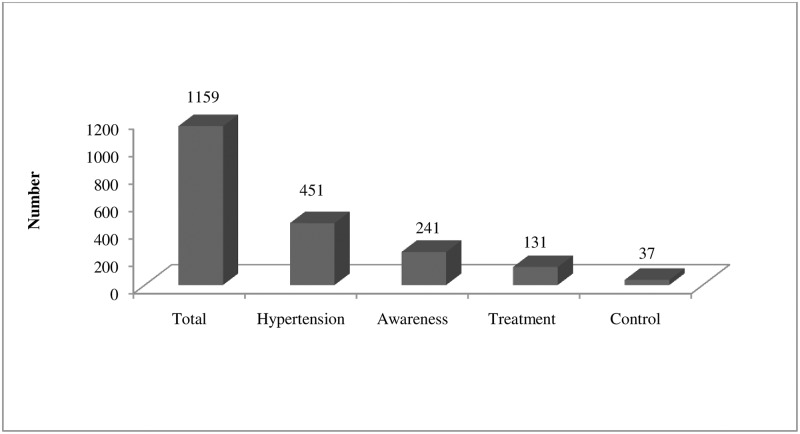
Summary of hypertension prevalence, awareness, treatment, and control.